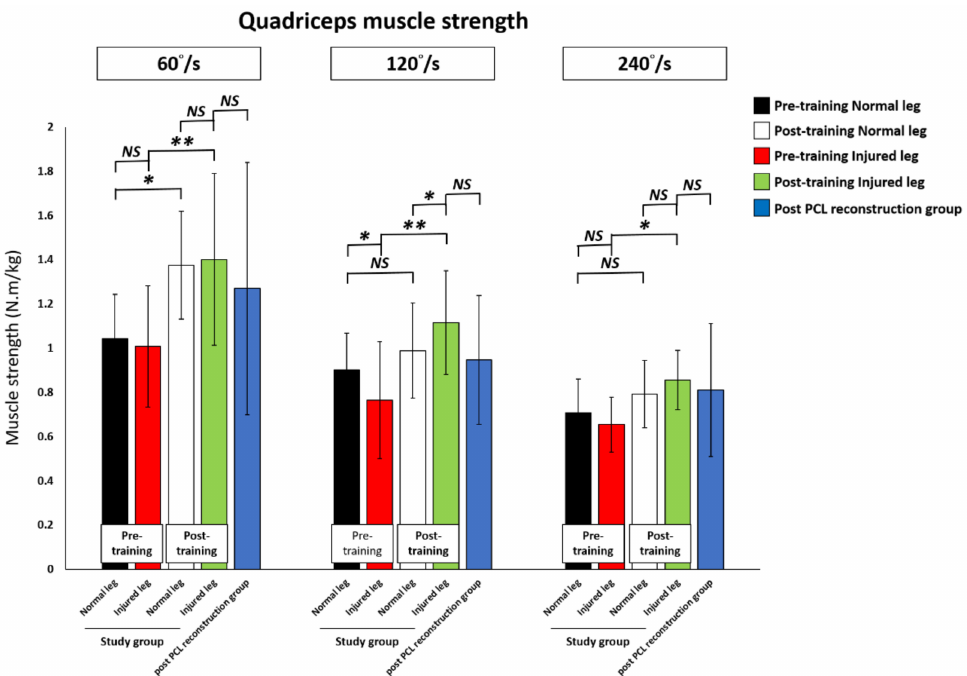
Figure 7. Comparison of hamstring muscle strength change at pre-training, at post-training, and in the post-PCL reconstruc- tion group. PCL: Posterior cruciate ligament. * p < 0.05 indicates statistical significance. ** p < 0.01 indicates high statistical significance between two groups. NS: No significant difference between two